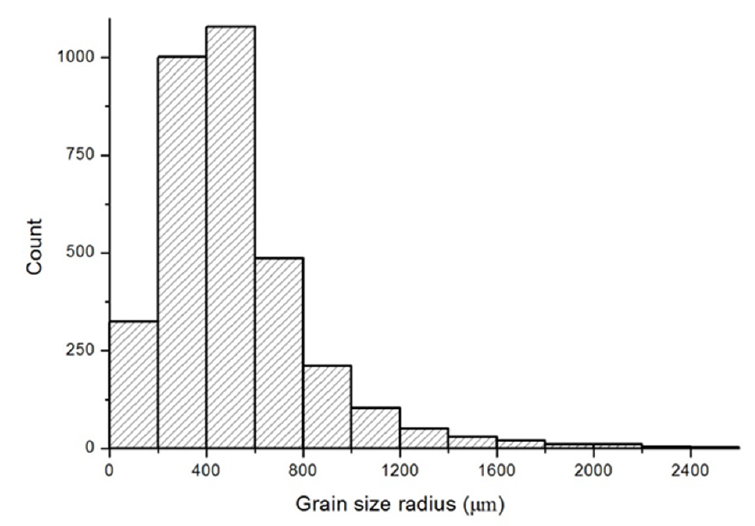
Figure 8. Ranges of snow particle size distributions in 2014 and 2015.